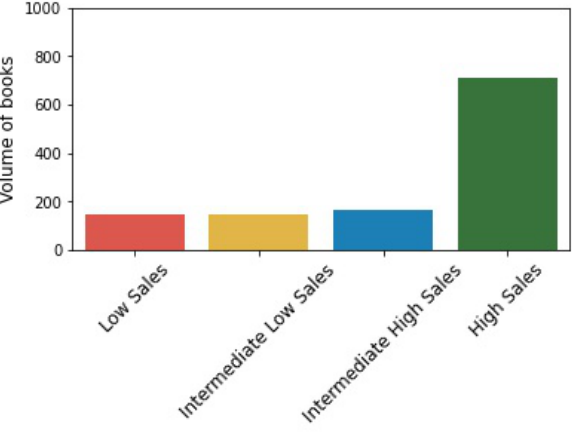
Figure 5. Distribution of the volume of books for each of the expert’s segmentations. The results show a significant data imbalance between the different segmentations.